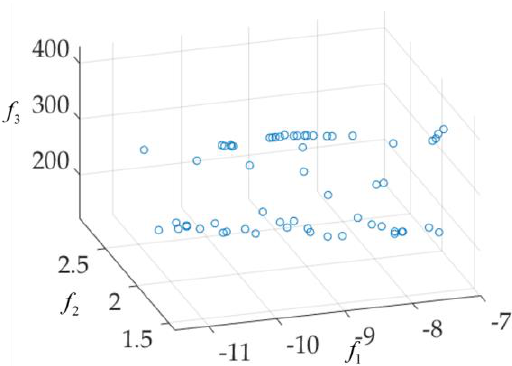
Figure 12. The applicable designs for the UWB antenna.